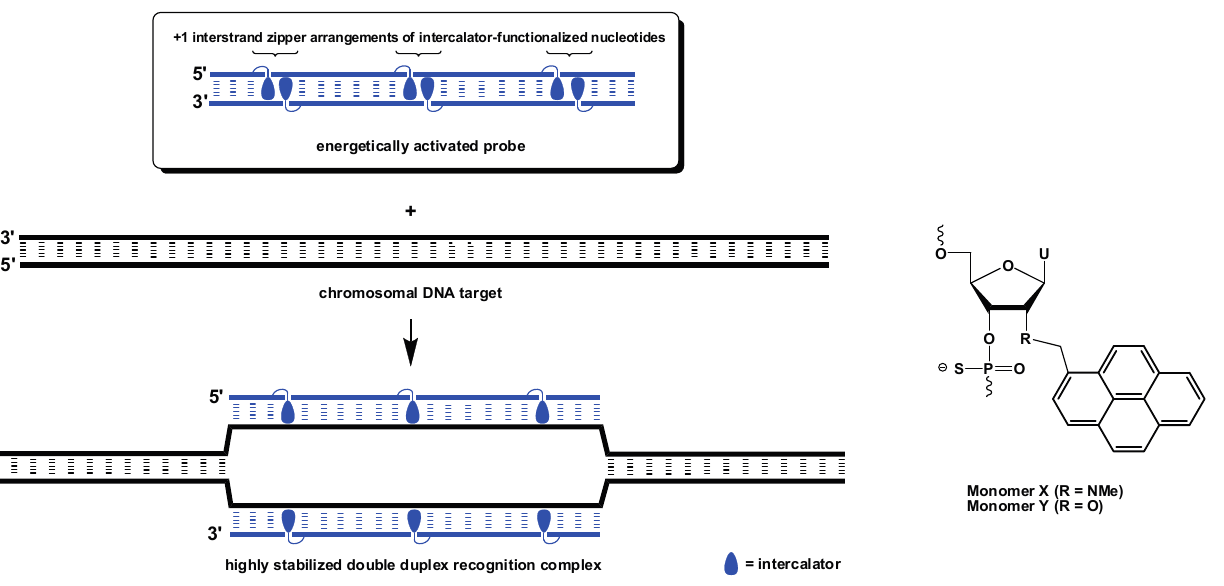
Figure 1. Illustration of the Invader approach for recognition of mixed-sequence dsDNA and structures of monomers used herein. Droplets denote intercalating pyrene